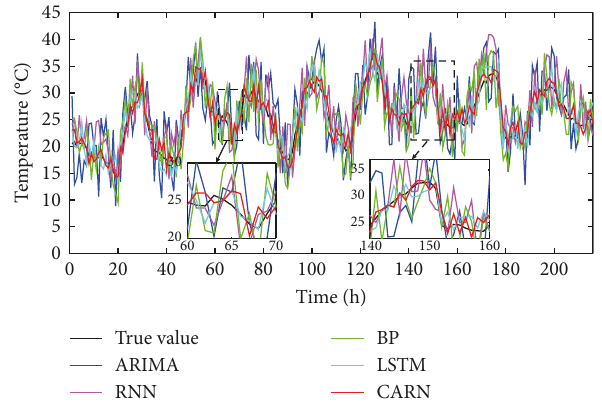
Figure 7: Prediction results of meteorological forecast data.